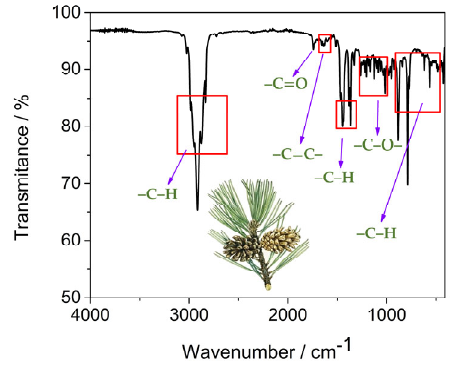
Figure 2. ATR spectrum of analyzed PN essential oil.